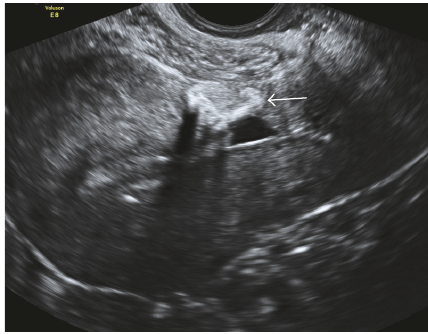
Figure 8: Avascular echogenic mass (16 × 15 × 10mm) at the site of caesarean scar (arrowed).